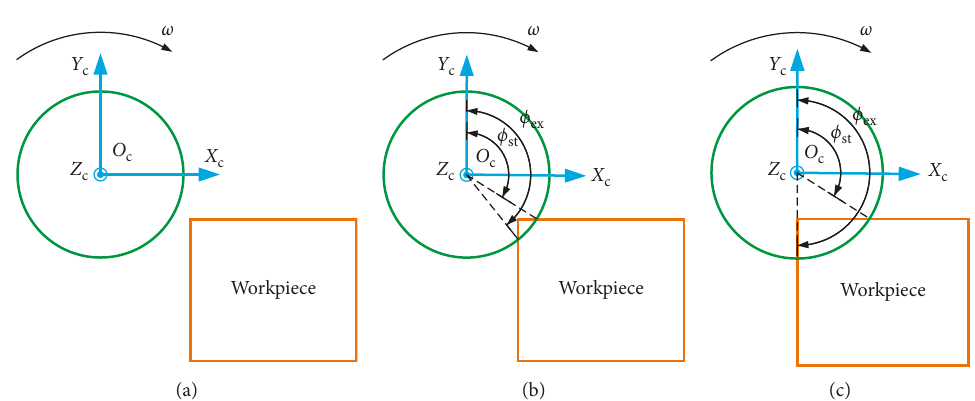
Figure 5: Division of the total procedure. (a) Uncontacted stage; (b) entering stage; (c) stable stage.